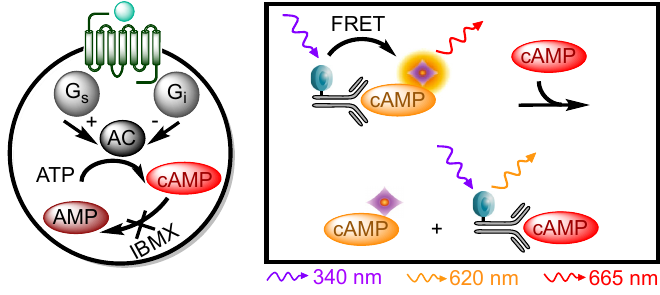
Figure 3. cAMP dynamic 2 assay principle. ( Left ) Upon ligand stimulation of the GPCR activation of G or G can occur. The G proteins either stimulate (G s i cyclase (AC), which converts ATP into cAMP. Degradation of cAMP is inhibited by IBMX; ( Right ) Endogenous cAMP competes with acceptor-labeled cAMP for the binding sites of a donor-labeled cAMP antibody. Hence accumulated cAMP will lead to a decrease in FRET signal and an inhibition of cAMP will increase the FRET signal.